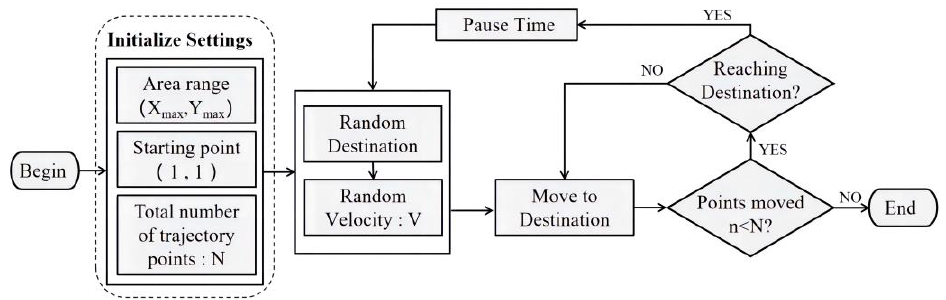
Figure 3. Schematic flow chart of RWP model.